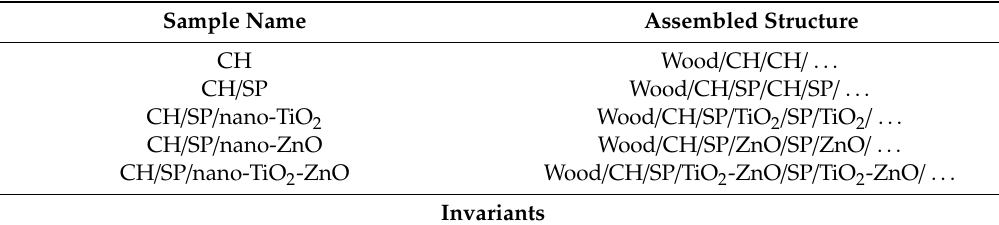
Figure 1. Scheme of fabricating flame-retardant coating on a wood surface by layer-by-layer self-assembly. Table 1. Assembly structure and invariants of coated samples.